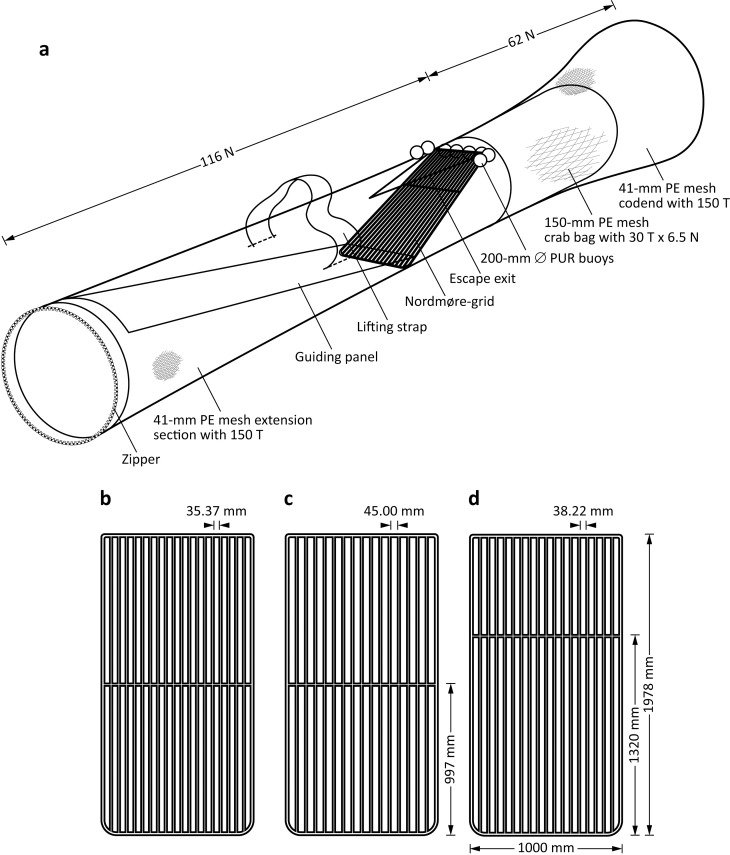
Specifications of the (a) extension and codend (with crab bag) assembly with a Nordmøre‐grid installed and (b) 35-, (c) 45- and (d) 38-mm grids tested. PE, polyethylene; PUR, polyurethane; T, transversals; N, normals; Ø, diameter.